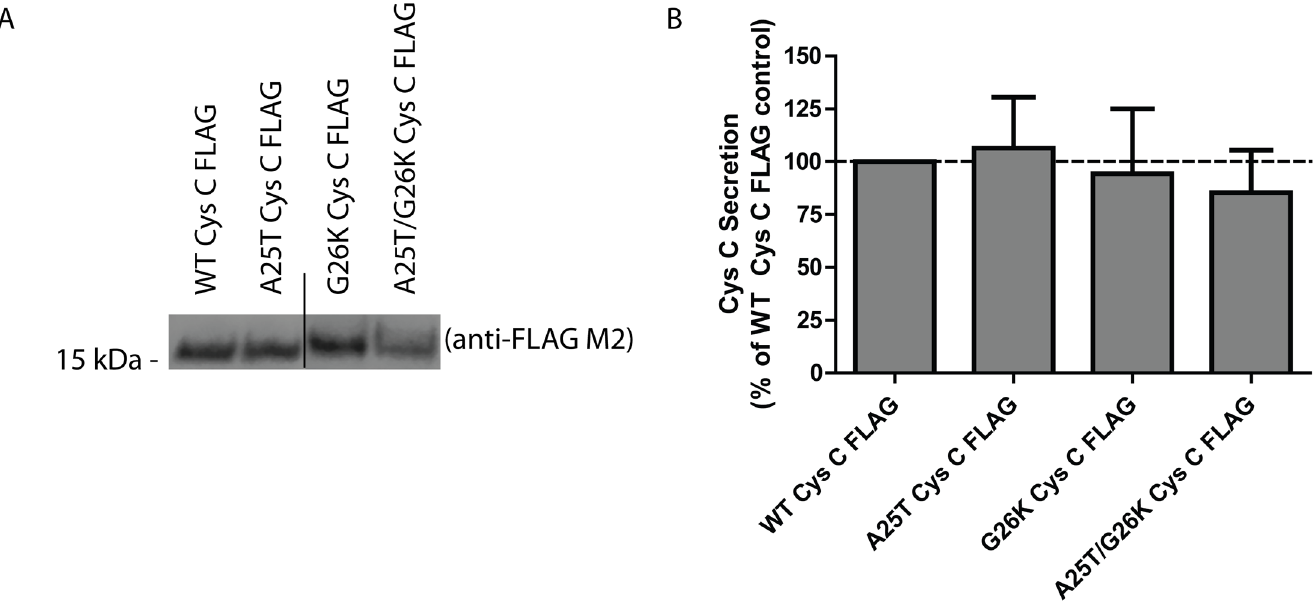
Fig 4. A G26K mutation eliminates Cys C signal sequence cleavage at site 2, and favors site 1 cleavage. (A) WT, A25T, G26K or G26K/A25T Cys C FLAG constructs were transfected into HEK-293T cells and conditioned media samples were analyzed by western blotting. Representative data are shown for > 3 independent experiments. (B) LI-COR quantification of secreted levels of Cys C variants listed in (A), n (cid:1) 3, mean ± S.D.).